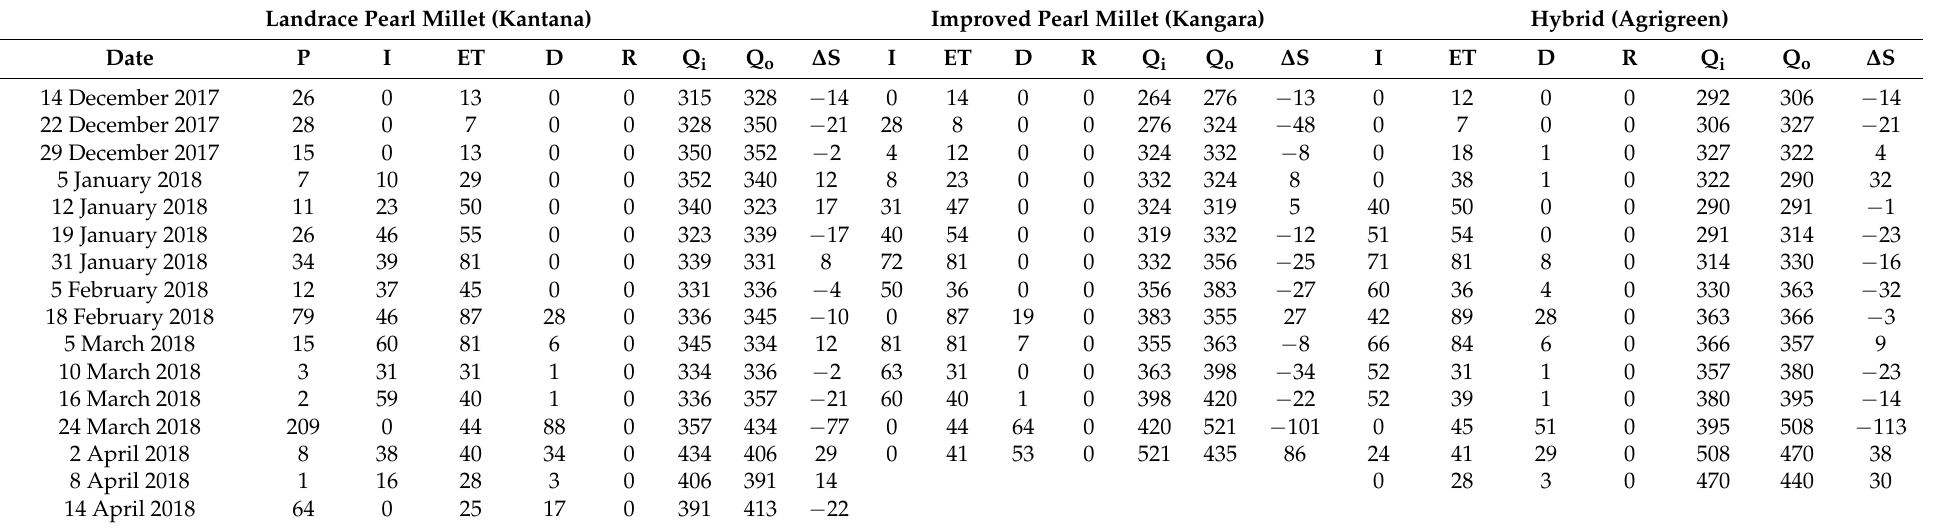
Table 1. Weekly soil water balance components (mm) for three pearl millet varieties (December–April of 2017/2018). Precipitation (P) and irrigation (I), evapotranspiration (ET), drainage (D), runoff (R), amount of water contents at the beginning of a measurement period in the root zone (Q o ), amount of water contents at the end of a measurement period in the root zone (Q i ) and change in water storage ( ∆ S). Landrace Pearl Millet (Kantana) Improved Pearl Millet (Kangara)